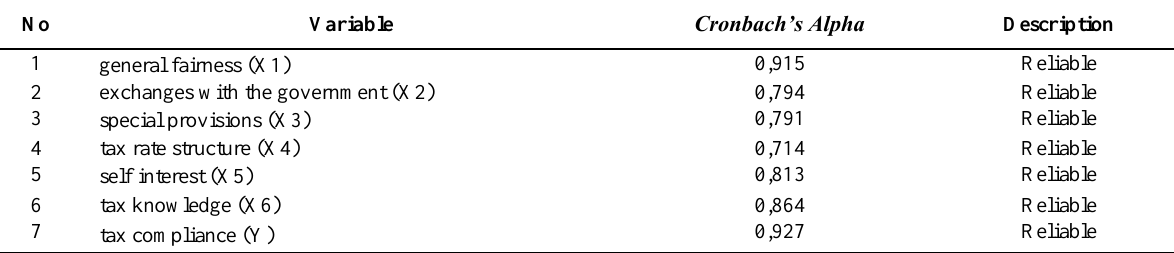
Table 1: Reliability Test